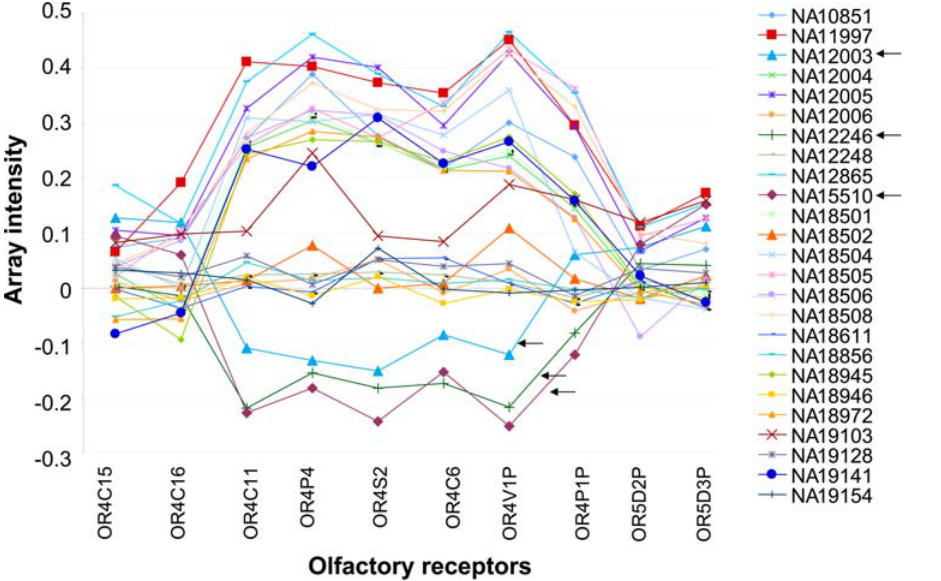
Figure 5. Zoom into a bi-allelic CNV affecting OR4C11. Plot depicting median normalized log 2 -ratios of microarray intensities for OR loci affected by deletion I (chr11: 55127497–55238834), a bi-allelic CNV. Each individual is color-coded as indicated in the legend shown to the right. Black arrows indicate samples that consistently failed to produce results in the qPCR and standard PCR assays, indicating a potential homozygous deletion.